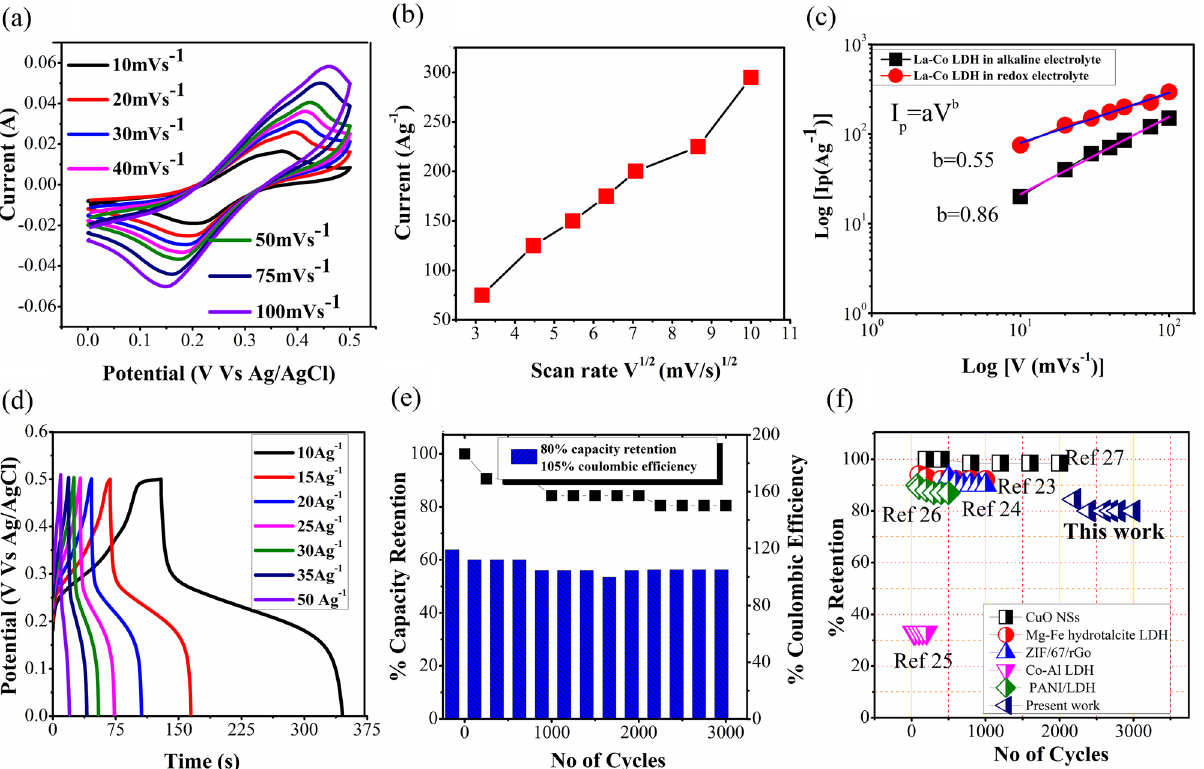
Figure 3. ( a ) CV cyclic voltammetry of La–Co LDH with redox electrolyte, ( b ) peak current vs scan rate V 1/2 plot of prepared electrode material in redox electrolyte, ( c ) separation of capacitive and diffusion controlled contribution with Power law, ( d ) Galvanostatic charge discharge measurement at various current densities in redox electrolyte, ( e ) cyclic stability of La–Co LDH electrode material in redox electrolyte, ( f ) the comparative cyclic stability plot of La–Co LDH with reported LDH based materials tested in redox electrolyte 23–27